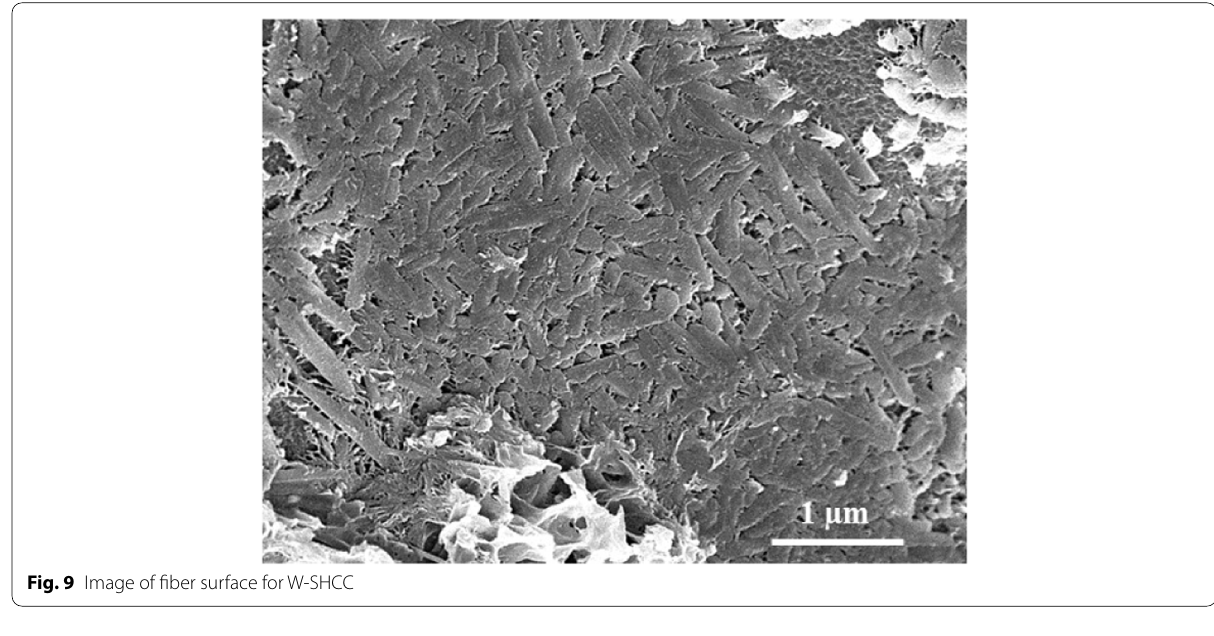
Fig. 9 Image of fiber surface for W-SHCC